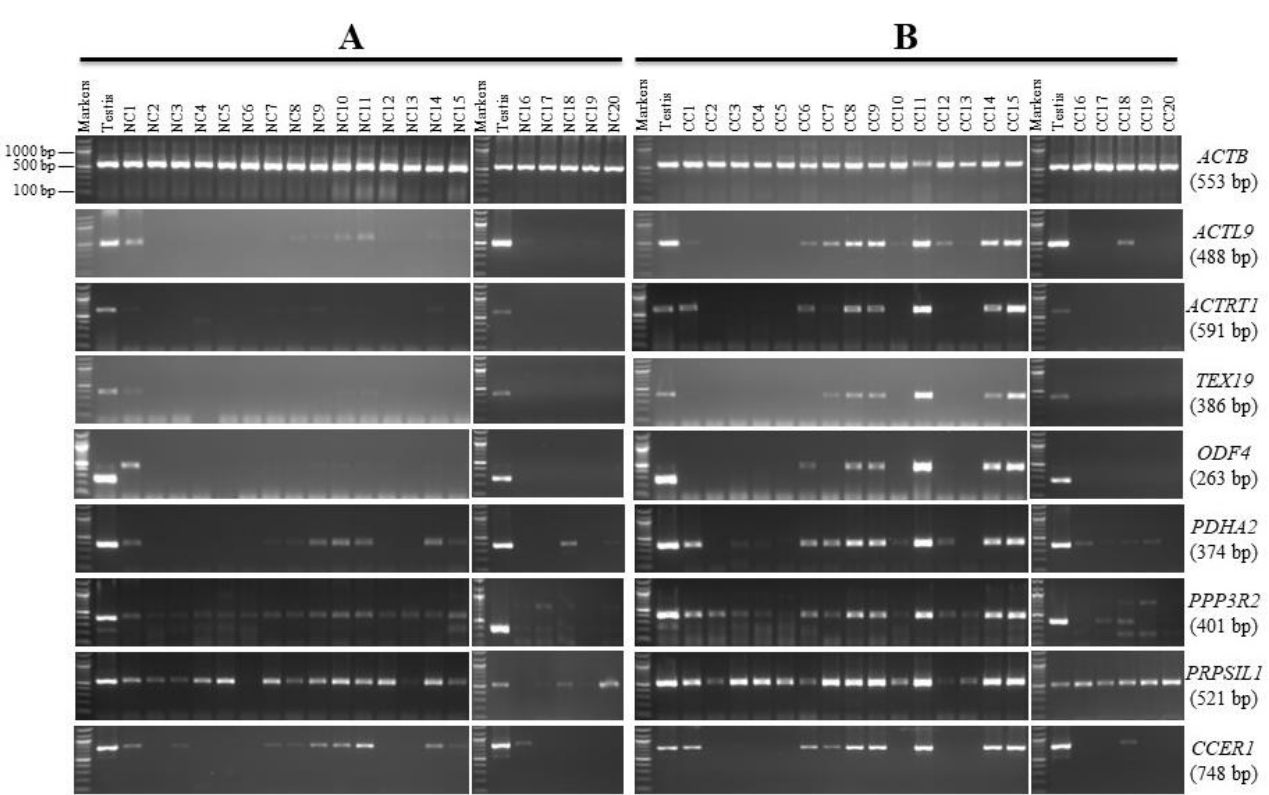
Figure 1. RT-PCR expression profiles for the ACTL9, ACTRT1, TEX19, ODF4, PDHA2, PPP3R2, PRPSIL1, and CCER1 genes in matching normal colon (NC) and colon cancer (CC) tissues. Agarose gels display the RT-PCR analysis for the ACTL9, ACTRT1, TEX19, ODF4, PDHA2, PPP3R2, PRPSIL1, and CCER1 genes. cDNAs were synthesized from the total RNA from 20 NC tissues ( A ) and CC tissues ( B ). ACTB expression was used as a positive control for the cDNA samples. Testis cDNA was used to test the primer for each gene. The expected product size of each gene is presented on the right between brackets.